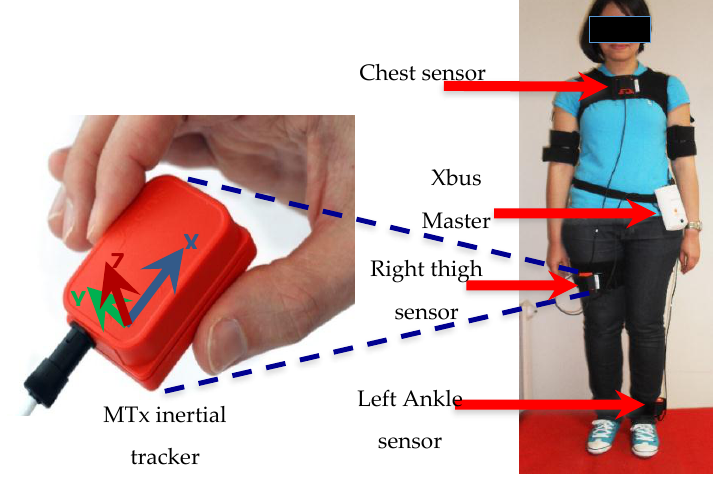
Figure 4. MTx-Xbus inertial tracker and sensors placement.